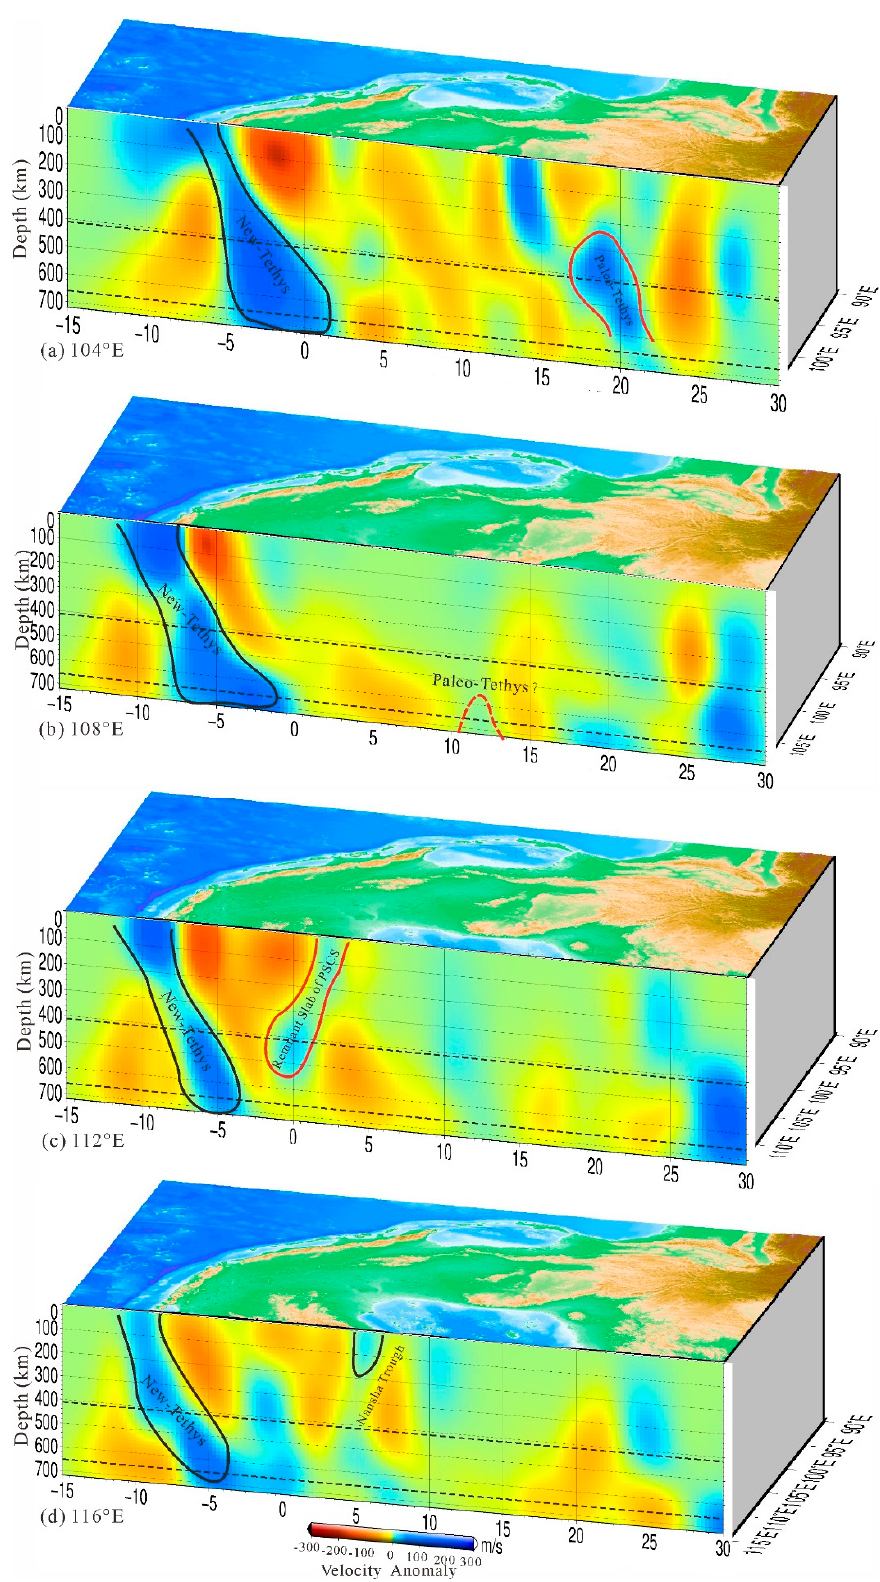
Figure 13. Four vertical slices of the P-wave velocity tomography along the longitude direction. (a) Vertical slice along 104°E; (b) Vertical slice along 108°E; (c) Vertical slice along 112°E; (d)Vertical slice along 116° E. Red color and blue color represent low and high velocity anomalies, respectively. The two dashed lines in the slices indicate the 410 and 660 km discontinuities, respectively. The velocity anomaly scale is shown at the bottom.